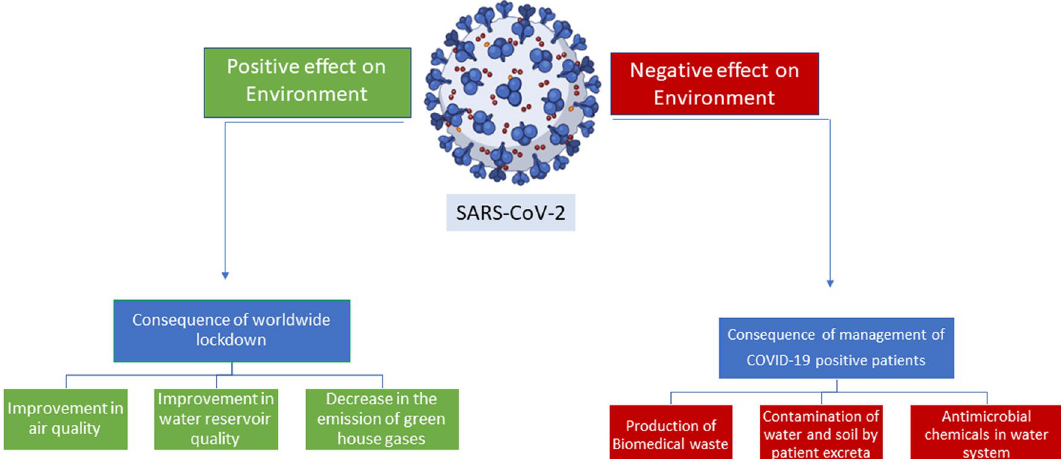
Fig. 1 A flowchart depicting the long-term positive and negative effects of SARS-COV-2 on the